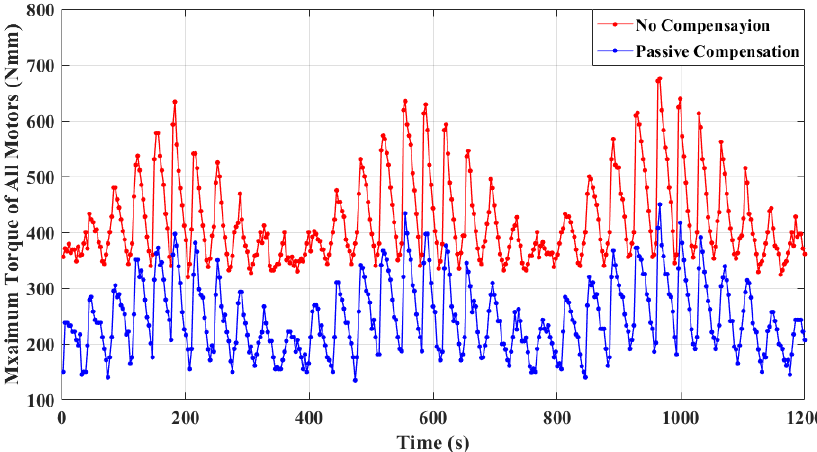
Figure 10. Maximum torques of joints in the case of no compensation and passive compensation.